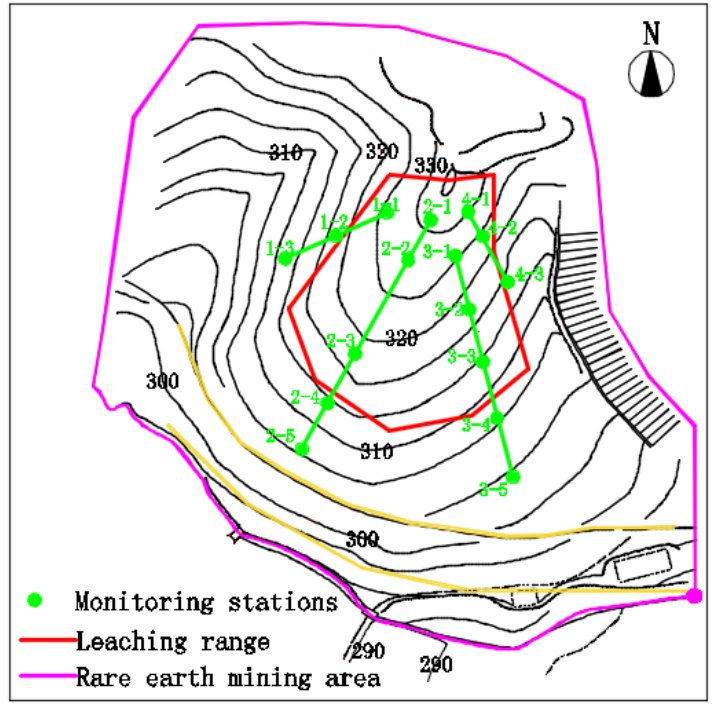
Figure 8. Layout of monitoring points in the testing site.